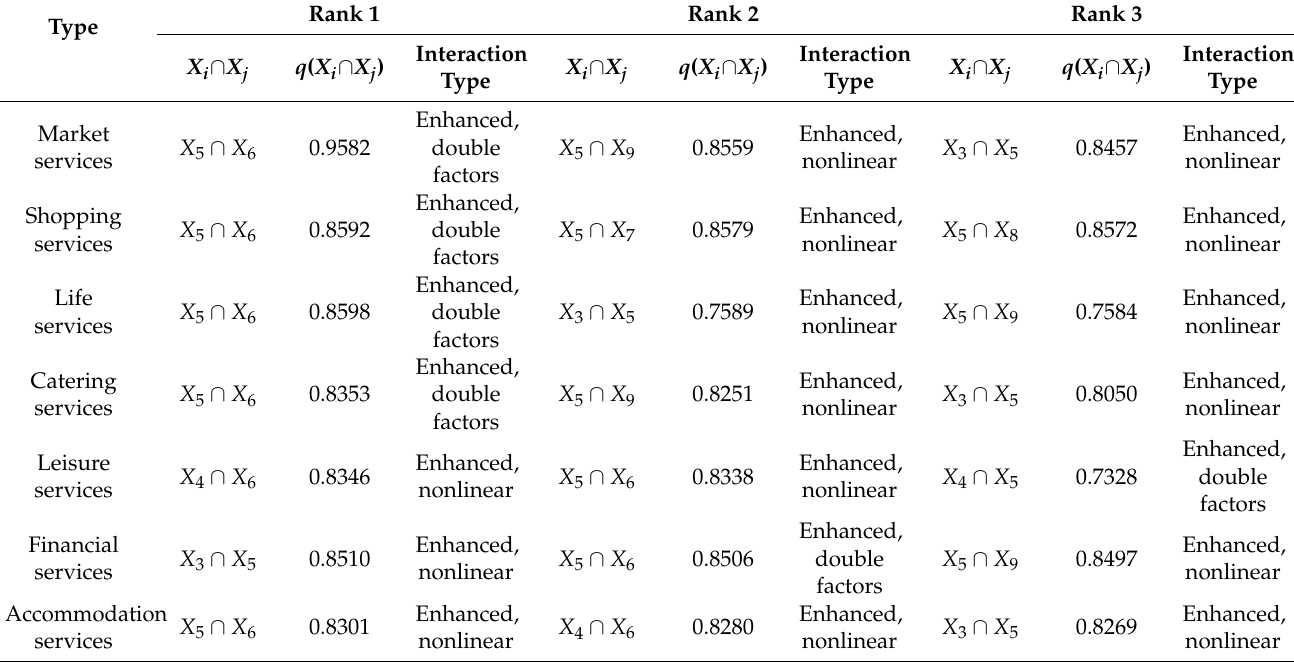
Table 8. Interaction detection results of factors influencing the spatial characteristics of different types of market services industries in Wuhan city’s new urban